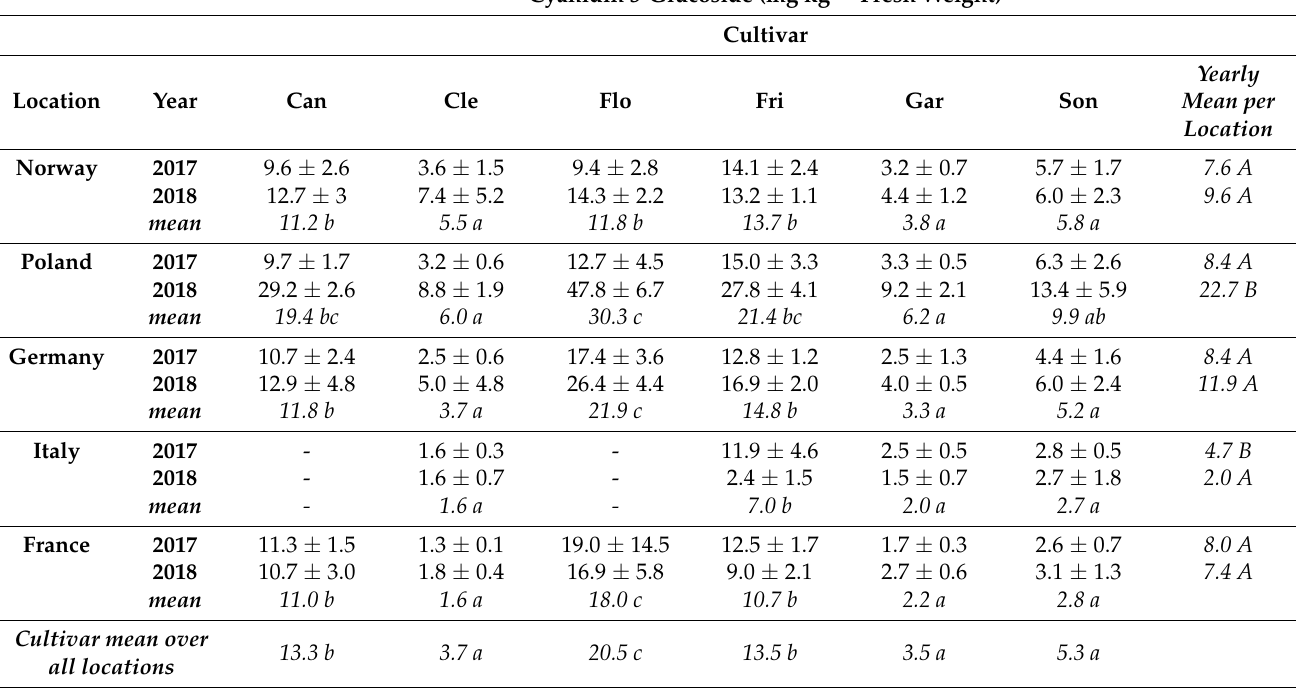
Table 3. Effect of growing location and year on cyanidin 3-glucoside content as the mean of two picking dates in fruits of six strawberry